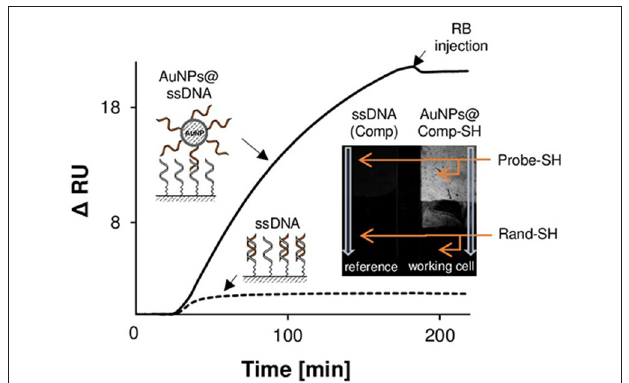
FIGURE 5 | The influence of DNA probe surface density on efficiency of AuNPs-induced SPR signal enhancement (A) Schematic illustration of the mechanism of DNA-AuNPs@DNA duplexes formation on the example of monolayer of high DNA density (DNA-SH) and low DNA density (DNA-DTC). (B) The SPR responses of various DNA receptor layers toward injection of AuNPs@ Comp-SH labels. AuNPs modified with thiolated random sequence ( Rand-SH ) were injected into the reference cell throughout